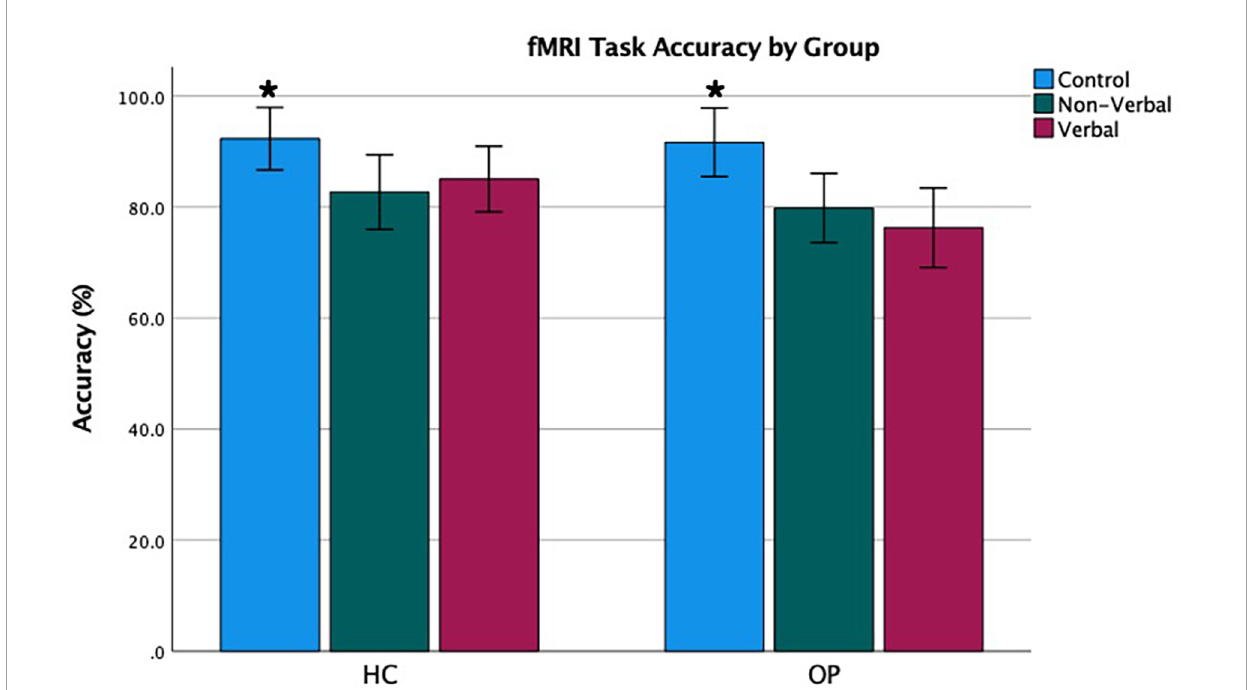
FIGURE2 Functional magnetic resonance imaging task accuracy by group. Error bars represent a 95% confidence interval of the true mean. *Accuracy was highest in the control condition.